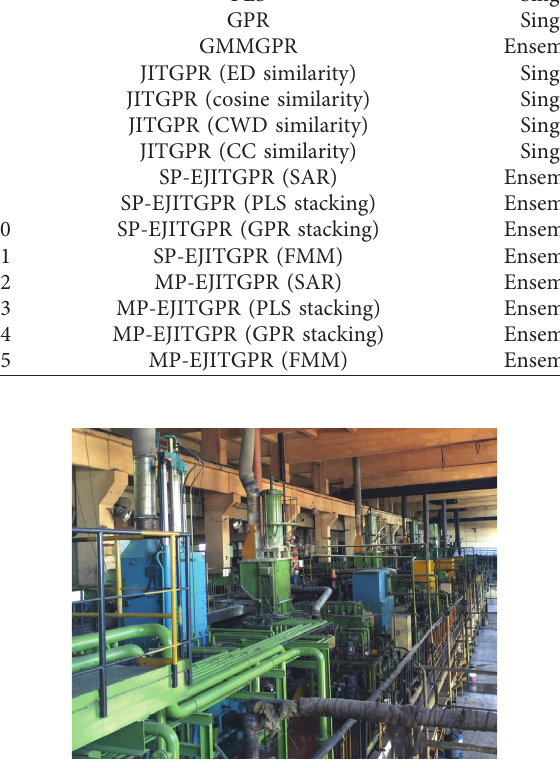
Figure 3: Industrial rubber mixing process. Table 2: Comparison of Mooney viscosity prediction results using different soft sensors ( l � 10 for JIT